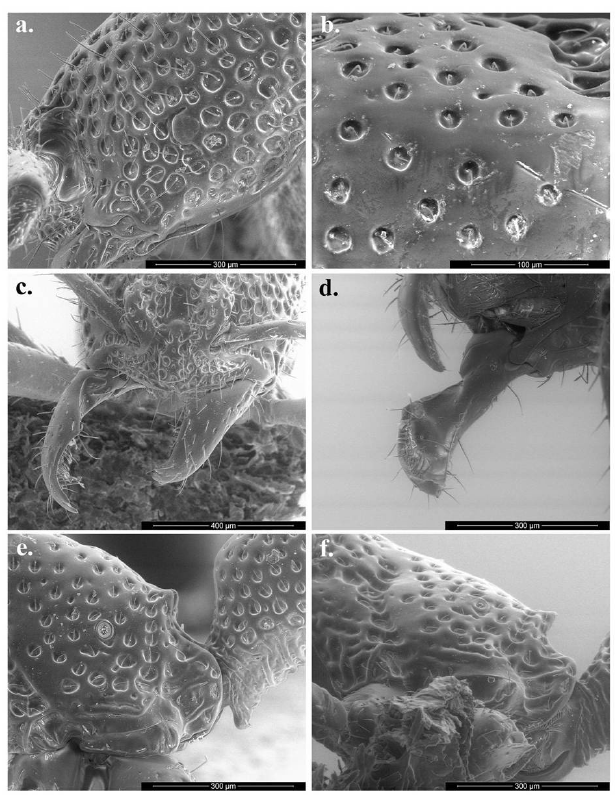
Fig 2. Close-up SEM pictures of Tyrannomyrmex rex illustrating the eye composed of 6 ommatidia ( a. ), the very short appressed hairs located within foveae on the pronotum ( b. ), the modified stout and cylindrical setae on the inner margin of the masticatory border of the mandible (dorsal view c. , lateroventral view d. ), the large and round propodeal lobe ( e. ), and an oblique view of the metapleuron